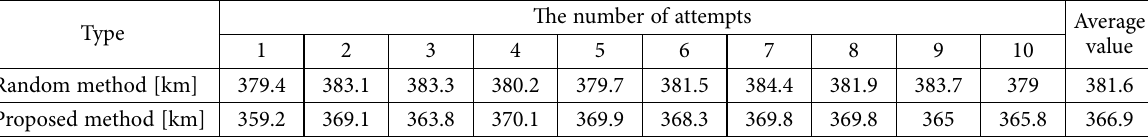
Table 1. The length of minimal assignment-route